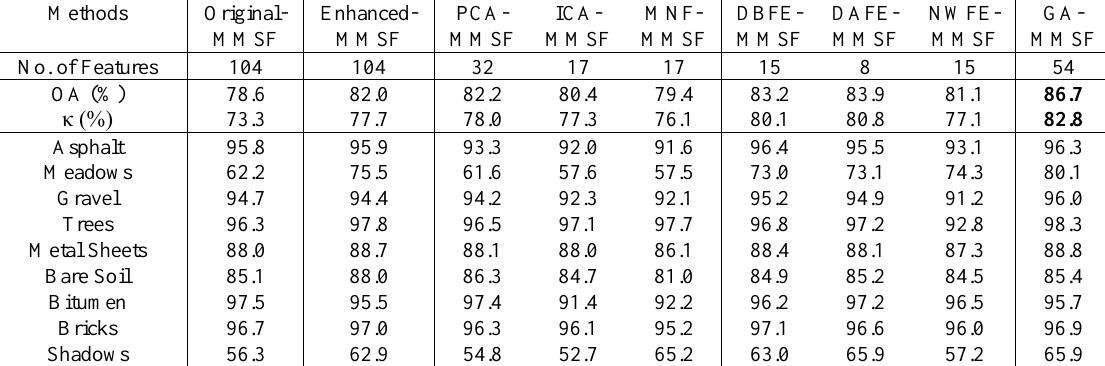
Table 4. The number of features and accuracy values